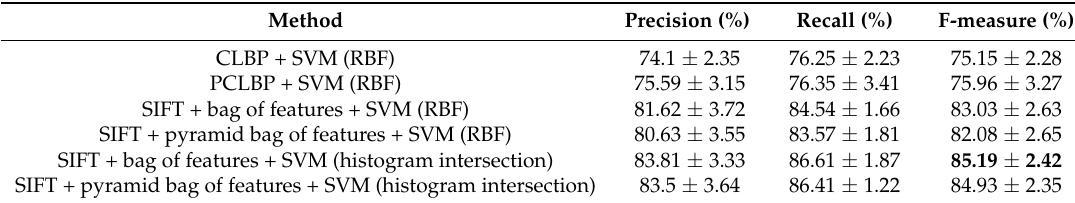
Table 6. Weighted average precision, recall and F-measure of the proposed method and benchmarks. Bold value indicates the highest F-measure. CLBP, Completed Local Binary Pattern; SVM, Support Vector Machine; RBF, Radial Basis Function; PCLBP, Patched Completed Local Binary Pattern; SIFT, Scale Invariant Feature